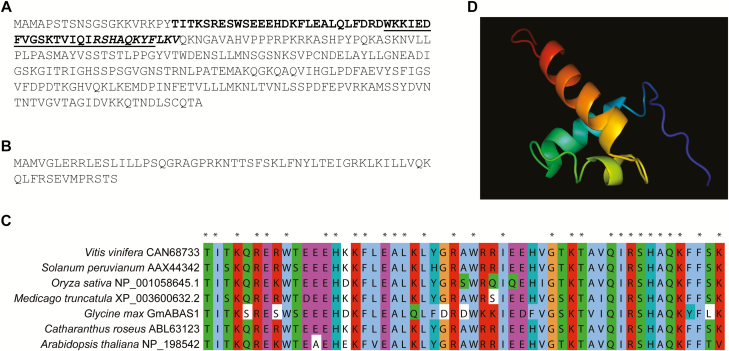

GmABAS1 encodes a 1R-subtype MYB. Translated amino acid sequence of (A) the intact GmABAS1 and (B) the truncated GmABAS1∆. Bold, helix–turn–helix (HTH) MYB-type domain; underlined, HTH motif; italic, nuclear localization signal. (C) Alignment of the HTH domain of 1R-subtype MYBs from Vitis vinifera CAN68733, Medicago truncatula XP_003600632.2, Solanum peruvianum AAX44342, Catharanthus roseus ABL63123, Oryza sativa NP_001058645, and Arabidopsis thaliana NP_198542 (Jia et al., 2009) with Glycine max GmABAS1 (this work). *indicates conserved amino acids. (D) The ribbon structure of GmABAS1 as predicted by the Phyre2 software. Red to purple, N-terminus to C-terminus.